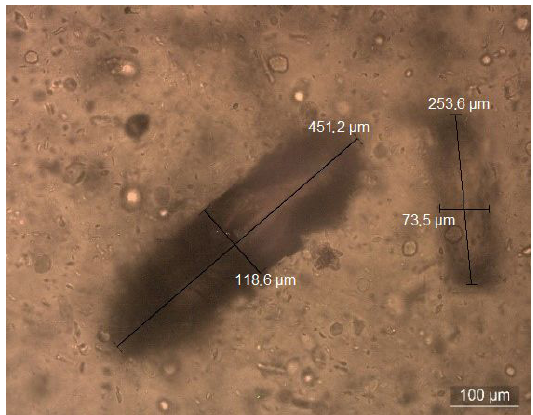
Figure 2. Photomicrograph of Macusanite with transmitted light and a total magnification of 200x.